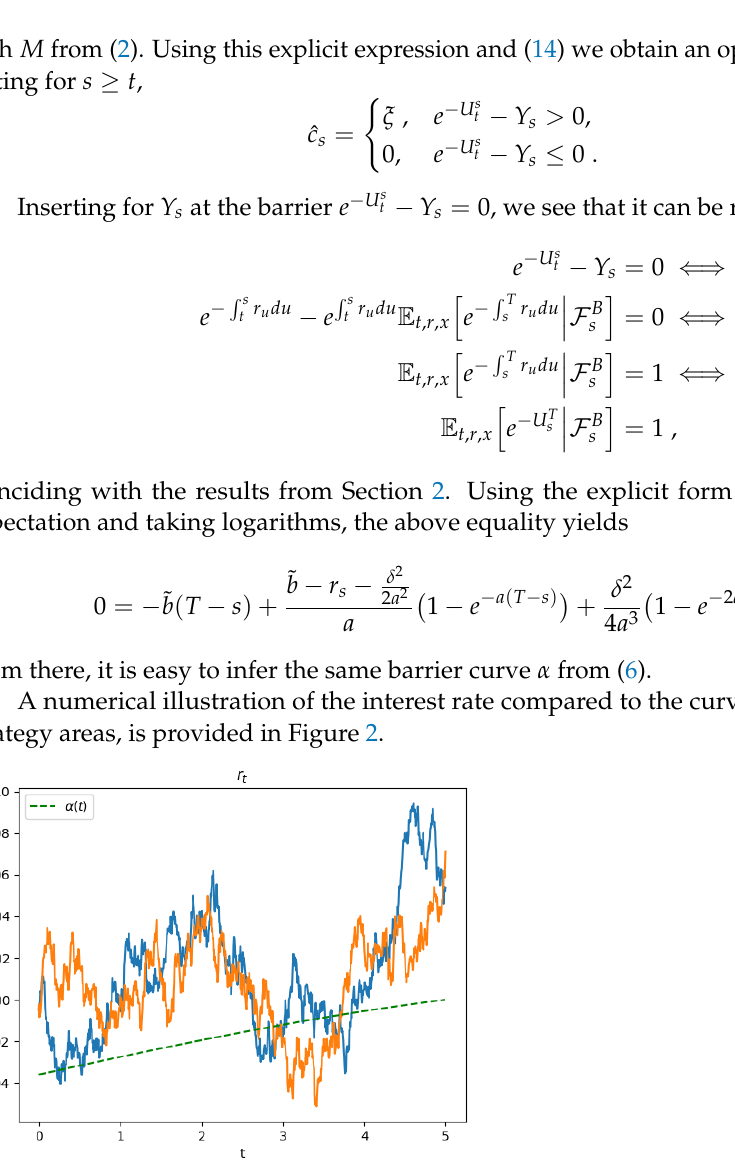
Figure 2. Two paths of r t in view of α ( t )